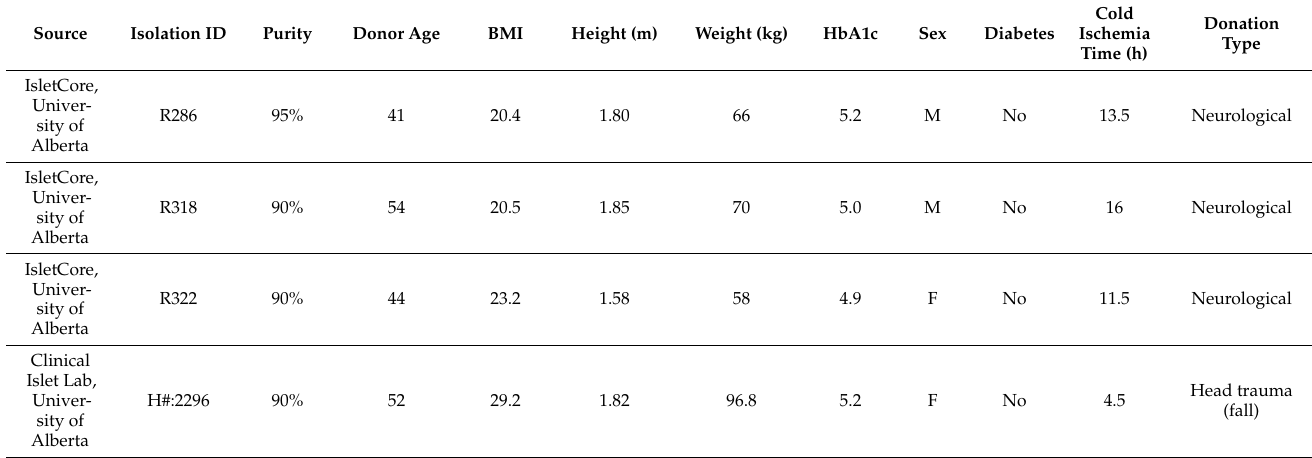
Figure 1. Human and murine islet insulin secretion in conditions of extremely high glucose. Islets from human donors ( A ) and mice ( B ) were placed in mannitol balanced KRB solutions containing glucose ranging from 0 mM to 144 mM for 1 h. Insulin secretion from each donor or mouse replicate was normalized to their respective maximal value and averaged. Dotted linear trendlines are drawn for 0–24 mM and 24–84 mM glucose to indicate slope, Spearman’s rho, and the respective p -value. Table 1. Human islet donor information.